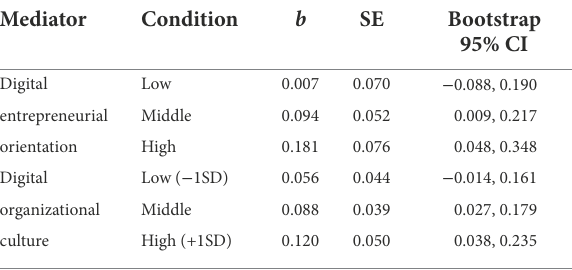
TABLE 4 Moderated mediation